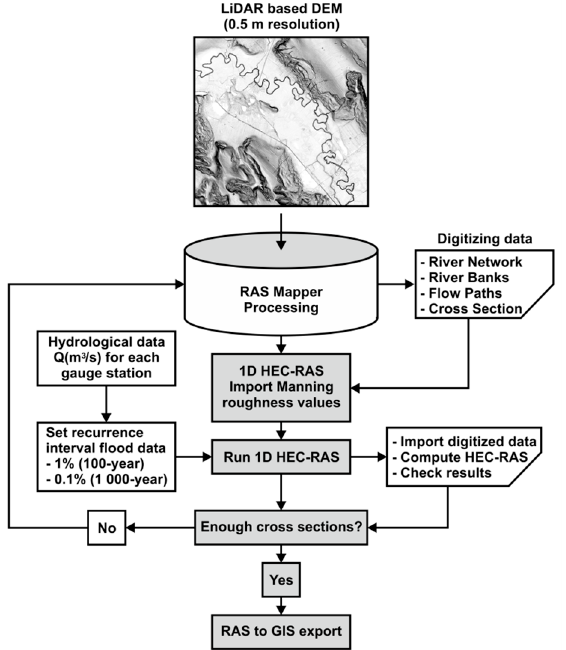
Figure 4. Methodological framework and detailed key steps followed for 1D HEC-RAS flood modeling and flood hazard